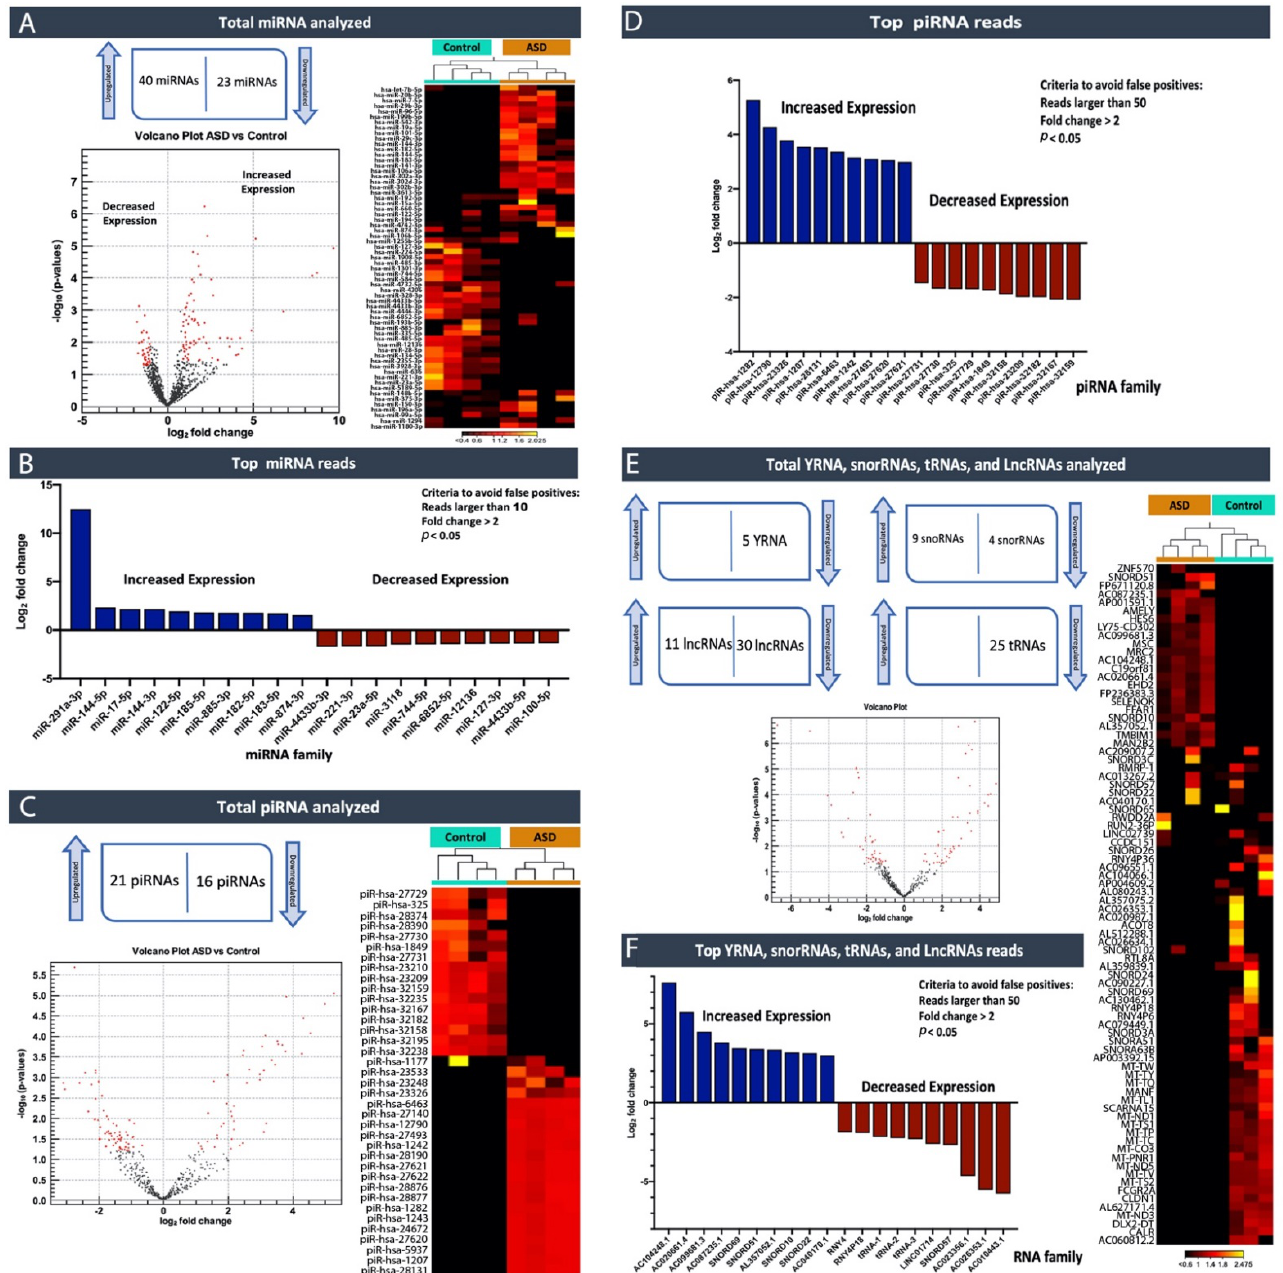
Figure 3. ncRNA expression analysis ASD individuals vs. Controls using CLC Genomics Workbench v20.0.4 (Qiagen, Germany) . ( A ) miRNA volcano plot (when using cutoff absolute fold change > 2, p -Value < 0.05, >10 reads per sample) and hierarchical clustering analysis of miRNA expression profile, a representative two-dimensional heatmap of expression values (4 Controls vs. 4ASD). Each column corresponds to one sample, and each row corresponds to a miRNA. The samples and features are both hierarchically clustered. ( B ) Top 10 differentially expressed miRNAs in ASD cases compared to control (Log₂ fold change > 2; p < 0.05). ( C ) piRNA volcano plot (when using cutoff absolute fold change > 2, p -Value < 0.05, > 50 reads per sample) and two-dimensional heat map of expression values. Each column corresponds to one sample, and each row corresponds to a piRNA. The samples and features are both hierarchically clustered. ( D ) Top 10 differentially expressed piRNAs in ASD cases compared to control. ( E ) Other ncRNA volcano plot (when using cutoff absolute fold change > 2, p -Value < 0.05, > 50 reads per sample) and two-dimensional heat map of expression values. Each column corresponds to one sample, and each row corresponds to a ncRNAs (Log₂ fold change > 2; p < 0.05). ( F ) Top 10 differentially expressed other ncRNAs in ASD cases compared to control.